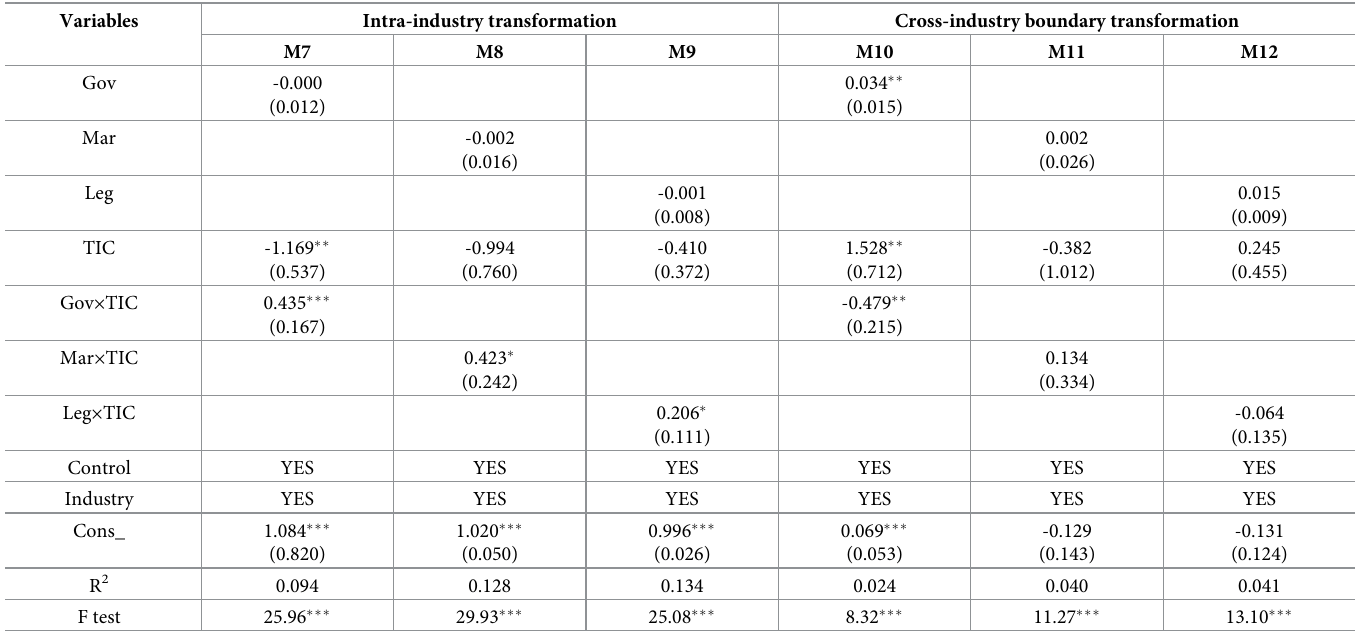
Table 5. The moderating effect of technological innovation capability on the relationship between institutional environment and service transformation.